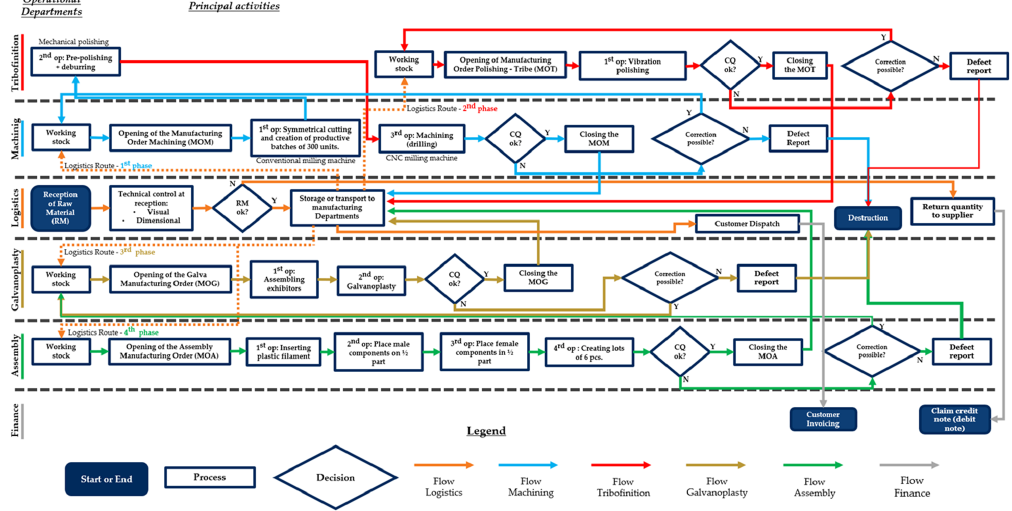
Figure 10. Representative flowchart of the “ring” production cycle.